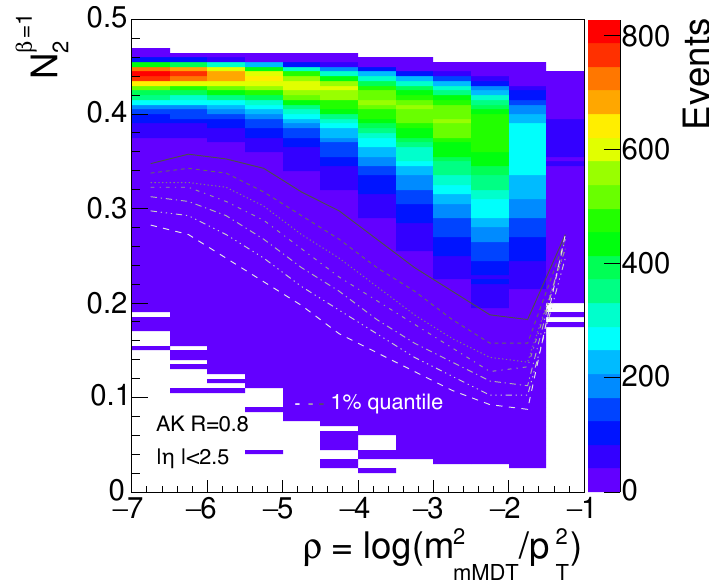
Figure 3 . Number of multijet events as a function (cid:26) = log( m 2 jet in the event. The lines correspond to the 1% quantile of the N (cid:12) =1 di(cid:11)erent jet p T bins. From top to bottom, the lines correspond to p T bins with lower borders at 200, 300, 400, 500, 600, 700 and 1000